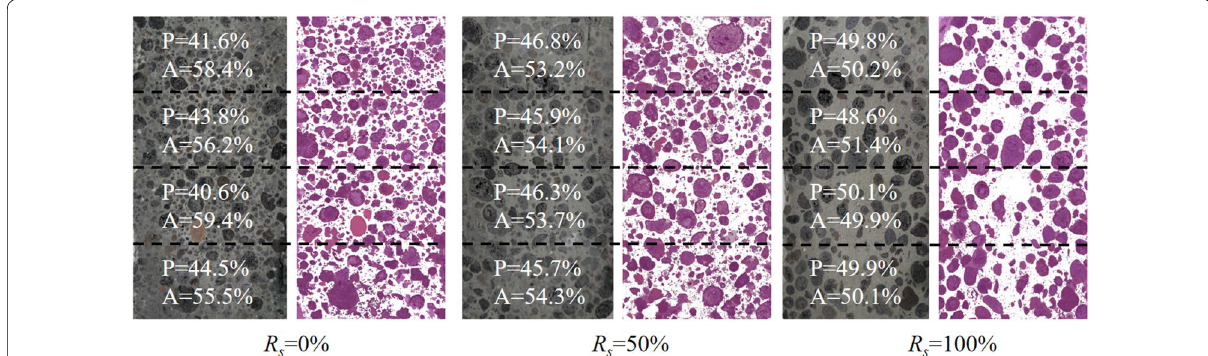
Fig. 4 Distribution of lightweight aggregate particles with respect to the height of cylinder specimens in the L‑group (Note: P and A indicate the cement matrix including natural sand and lightweight granules, respectively).